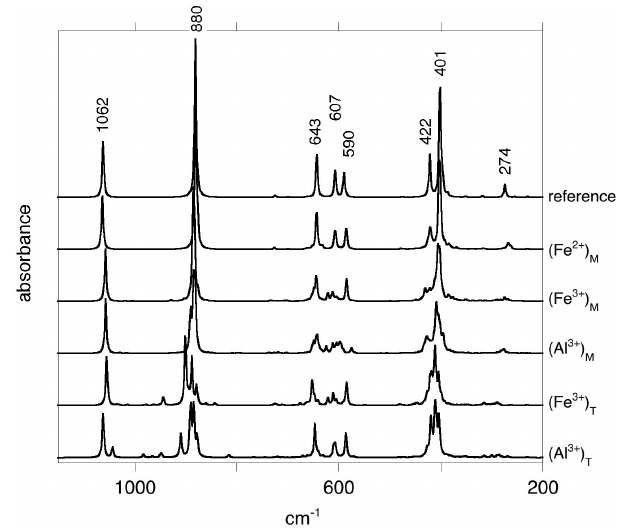
Figure 2. Theoretical absorbance spectra in the mid-infrared region of the Fe- and Al-bearing lizardite models. The reference spectrum corresponds to pure lizardite. The spectra have been computed as in Fig. 1. Note the very small modifications related to the occurrence of Fe 2 + ions in the octahedral